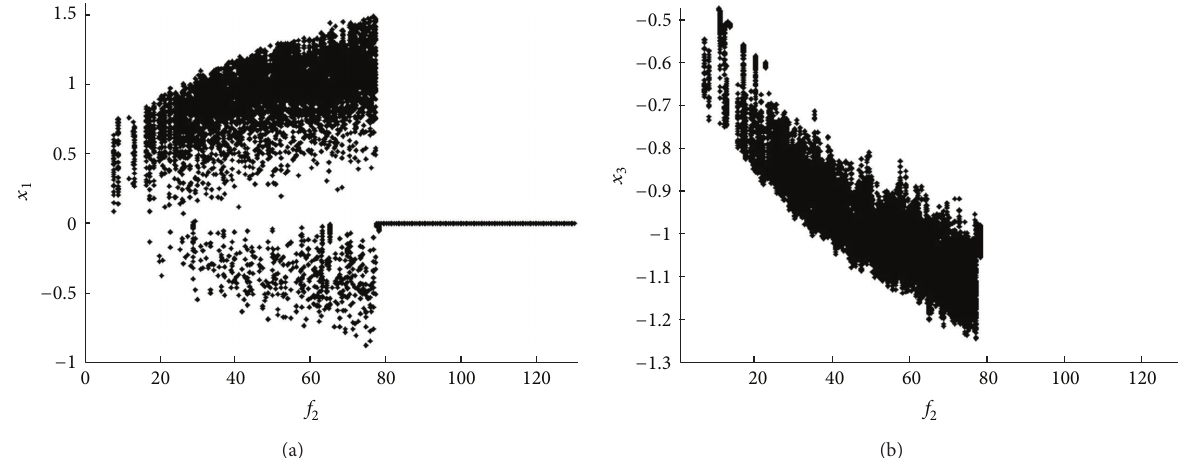
Figure 5: The bifurcation diagram is obtained for the excitations 𝑓 2 = 2 ∼ 130, 𝑥 10 = −0.01 , 𝑥 20 = −0.09 , 𝑥 30 = −0.05 , 𝑥 40 = −0.6 , 𝜎 1 = 3.31 , = 3.23 , 𝜇 = 0.1 , 𝜇 = 0.1 , 𝑎 = 11.59 , 𝑎 = 21.5 , 𝑎 = 13.7 , 𝑎 = −14.37 , 𝑎 = 10.39 , 𝑏 = −5.68 , and 𝑏 = −14.94 ; (a) the bifurcation 𝜎 2 1 2 2 3 4 6 7 6 7 diagram on the plane (𝑥 1 ,𝑓 2 ) ; (b) the bifurcation diagram on the plane (𝑥 3 ,𝑓 2 ) .